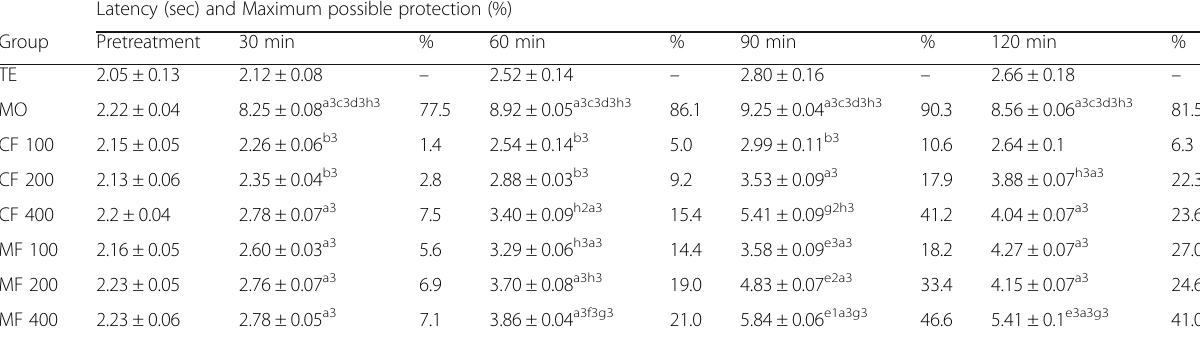
stenopetala respectively; control received 2% Tween 80 where as standard received Morphine orally; Numbers refer to doses in